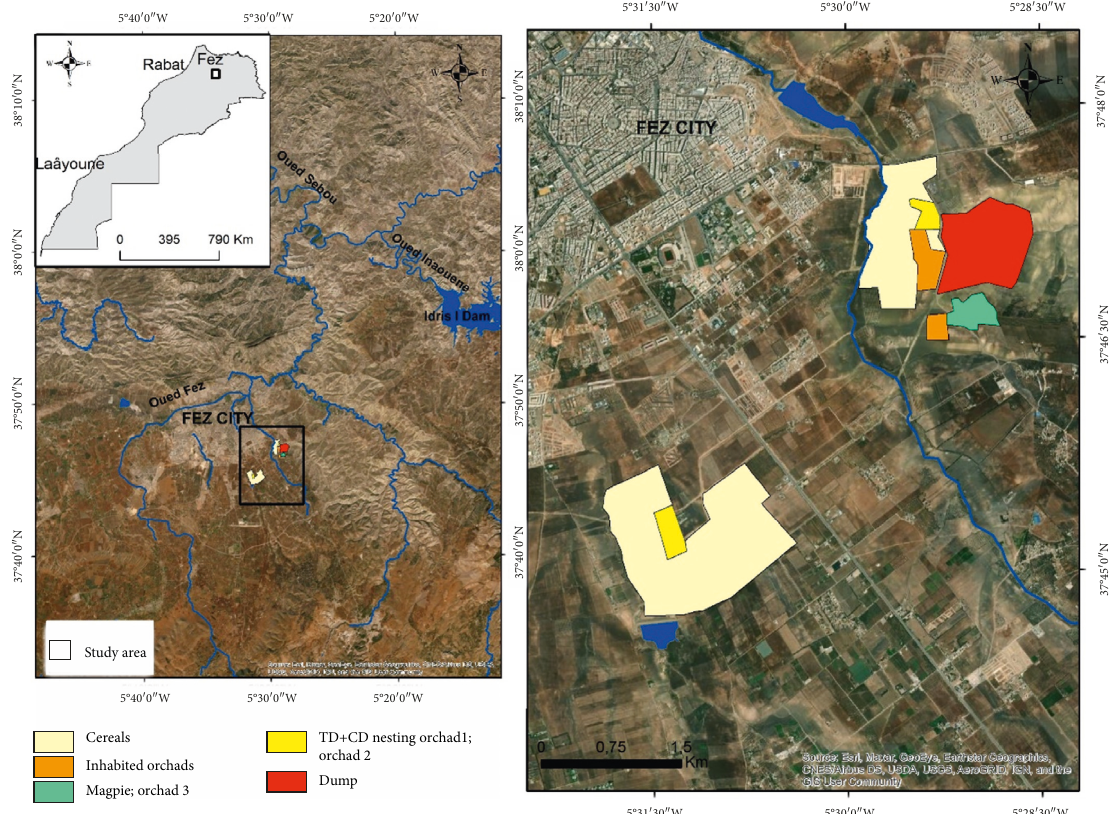
Figure 1: Map showing the location of the Sa¨ıss plain and breeding orchards used by turtle dove (TD), collared dove (CD), and Maghreb magpie (MGP) in the surrounding area of the Fes historical city